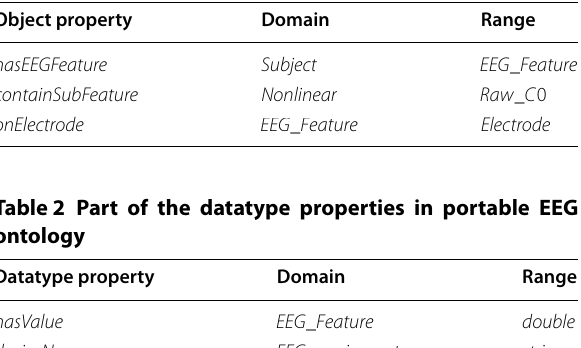
Table 1 Part of the object properties in portable EEG